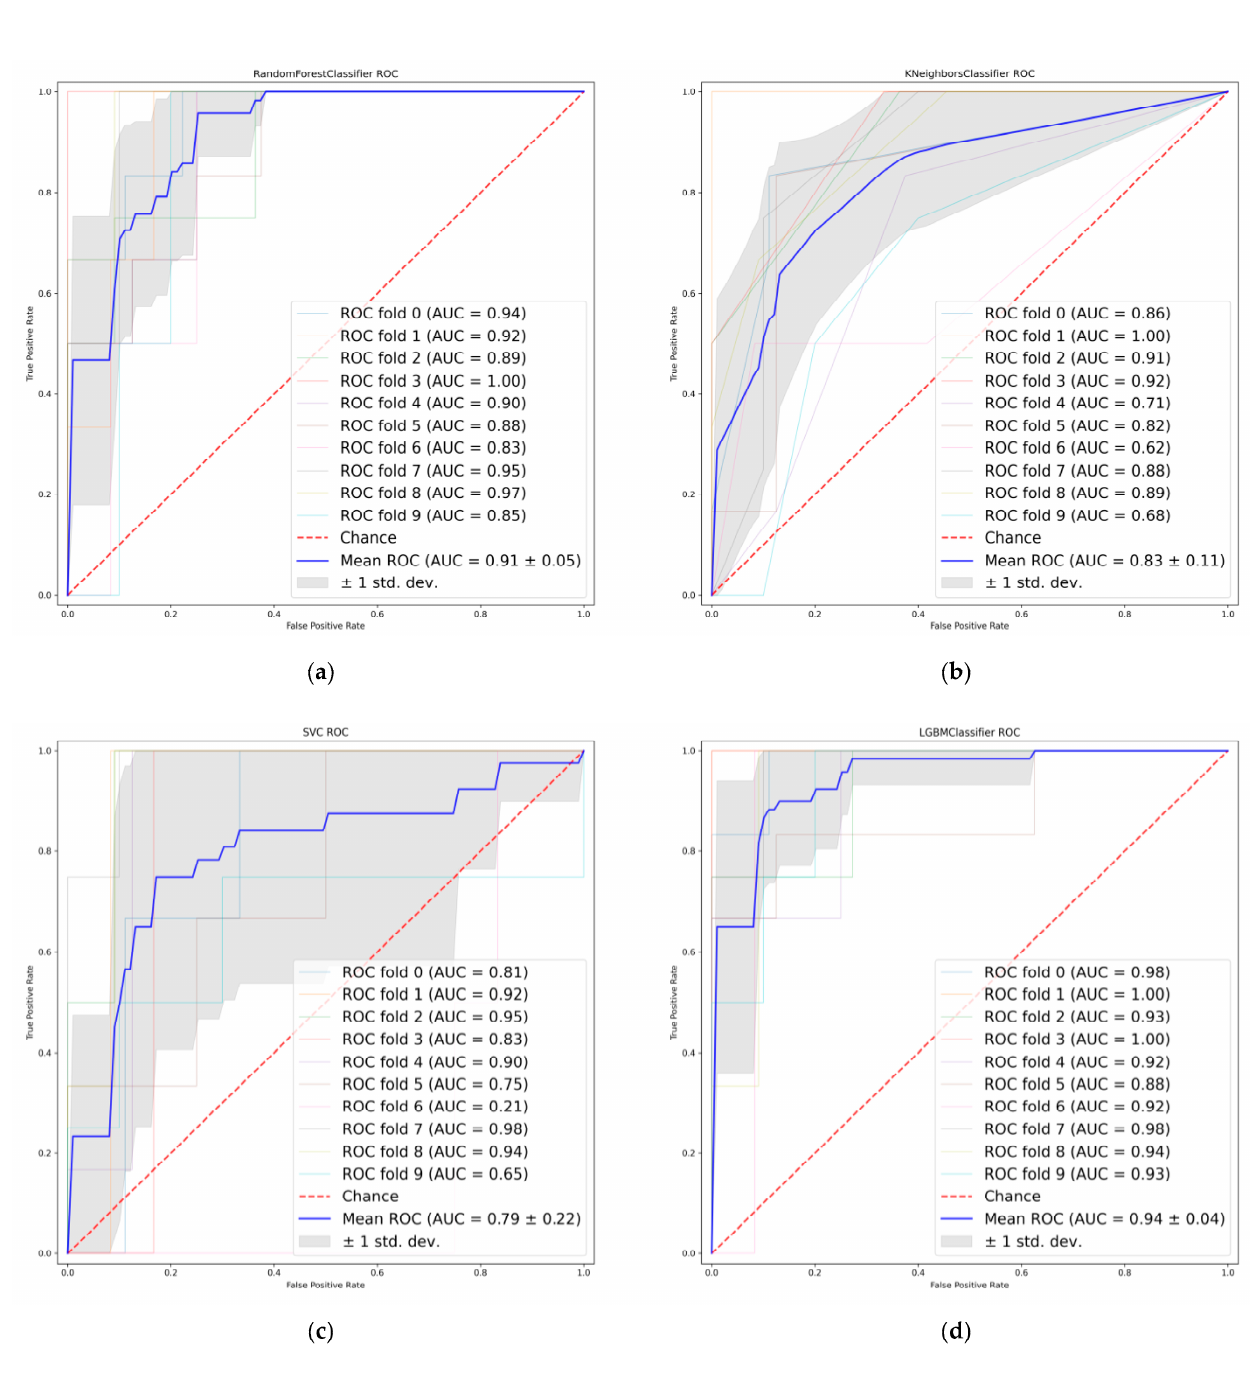
Figure 6. Receiver operating characteristics (ROC) curves when using the combined features. ( a ) Ran-